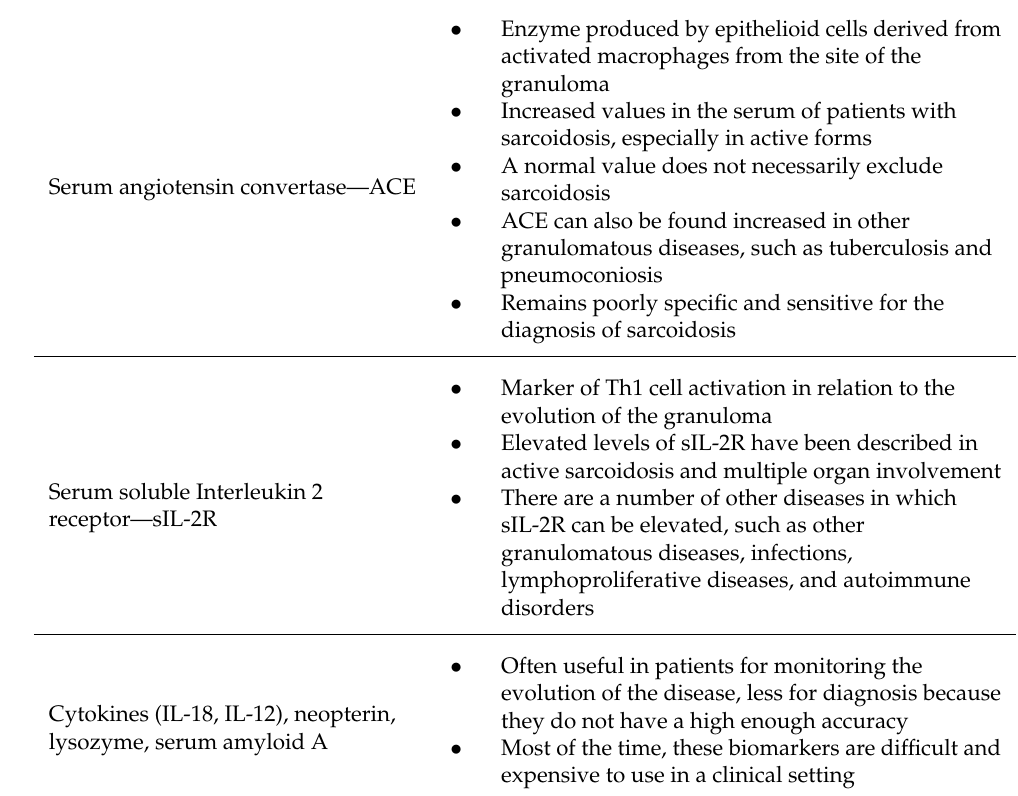
Table 2. Serum biomarkers in sarcoidosis